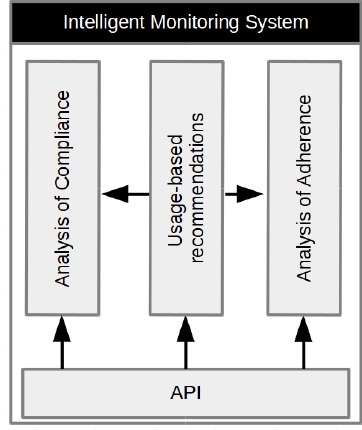
Figure 3. Intelligent Monitoring System